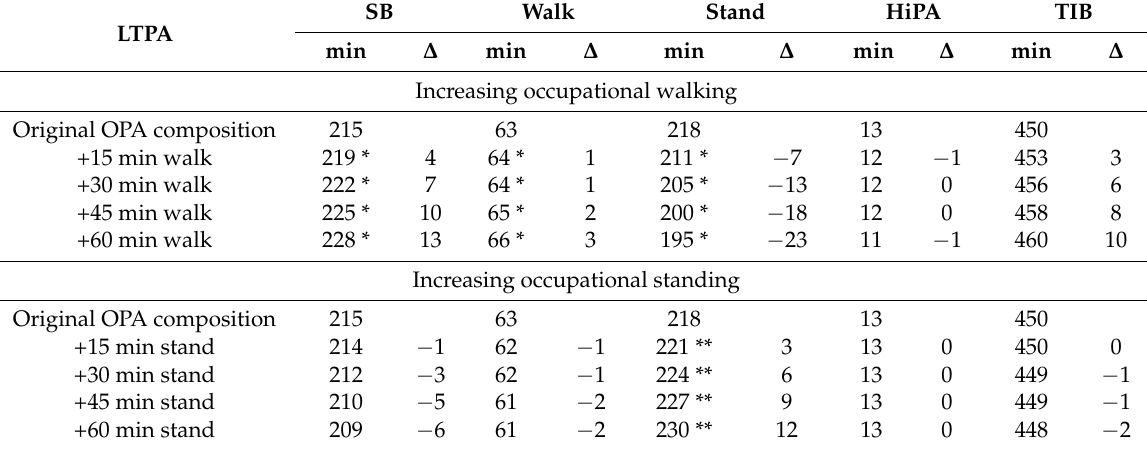
Table 7. Expected difference in LTPA following reallocation between occupational physical activities among women (N =